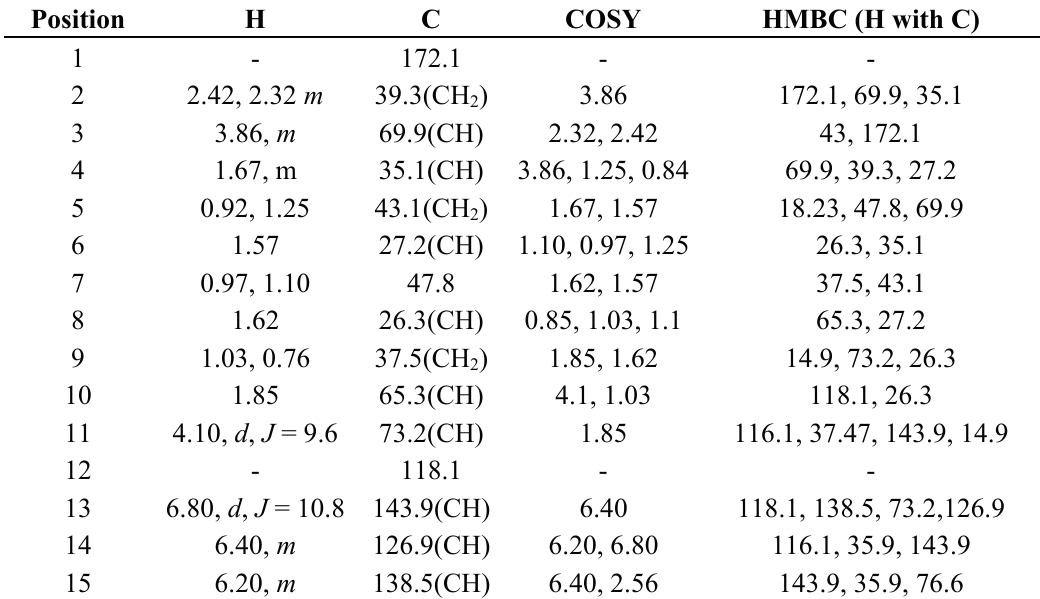
Table 2. 1 H- and 13 C-NMR, COSY and HMBC spectral data of compound ( MYA-3 ) (CDCl 3 ).